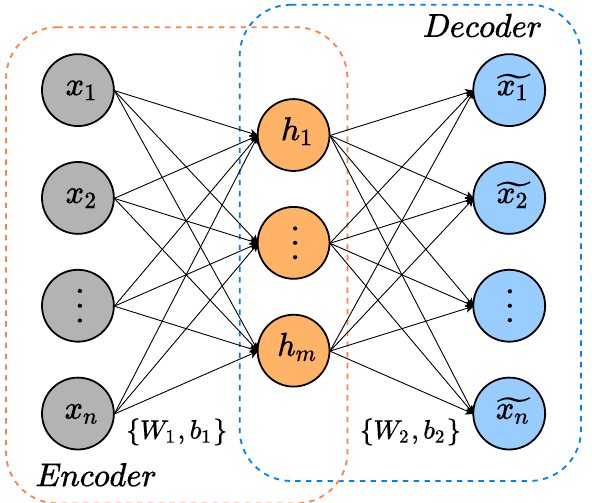
Figure 1. Basic AE